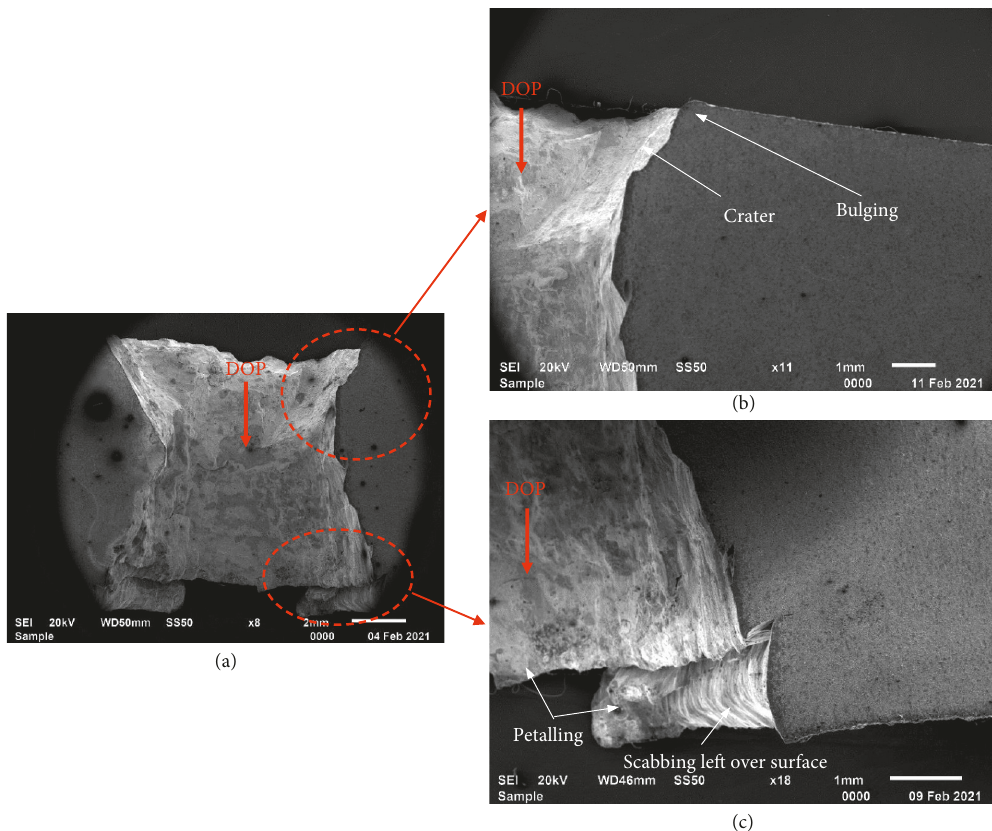
Figure 12: SEM SEI micrographs (a) of the penetration hole through a 10mm thick plate and (b and c) higher magnification micrographs of the circled areas in (a) at the entry and exit of the projectile hole in (b),